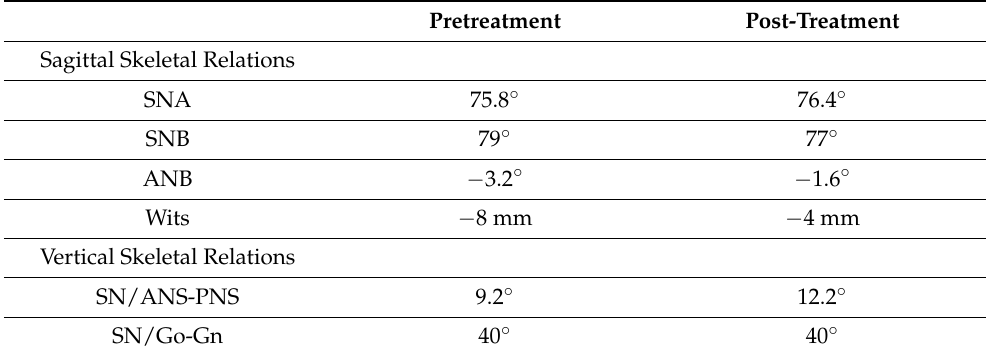
Figure 8. Superimposition of cephalometric tracings before treatment (black) and at the end of treatment (red): ( a ) general superimposition; ( b ) superimposition of the maxilla; ( c ) superimposition of the mandible. Table 1. Cephalometric